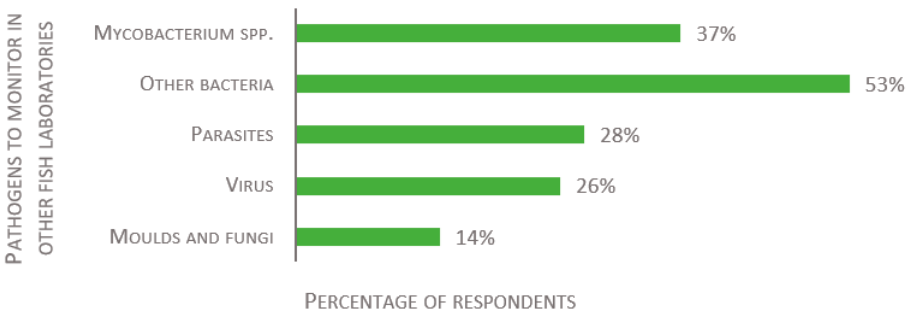
8 of 21 Figure 6. Replies to the multiple-choice question: “What do you think are the main pathogens to monitor in the zebrafish laboratory?”, presented as percentage of respondents ( n = 123). Each respondent was allowed to select multiple answers. For fish laboratories housing species other than zebrafish, the respondents were asked to list all important pathogens to monitor. Again, Mycobacterium spp. are the most often reported agents (37% of 43 respondents, see Figure 7). The remaining answers covered a wide range of infectious microorganisms, many being host specific. Answers were categorized to build Figure 7. Other oft-mentioned bacteria included Aeromonas spp., Flavobacterium spp., Vibrio spp., and Pseudomonas spp. Parasites included, for instance,